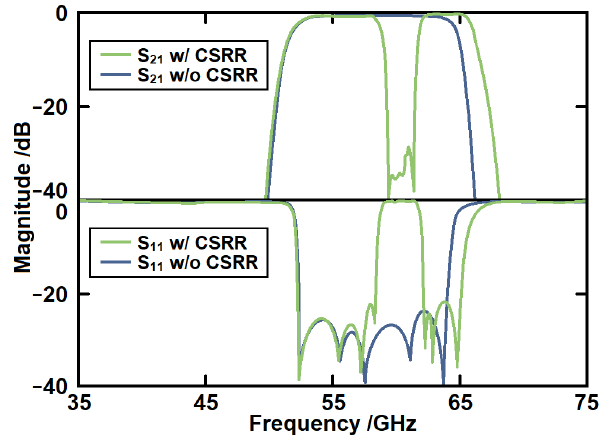
Figure 15. The simulated S -parameters of the serpentine line SSPP with and without CSRR struc- tures.